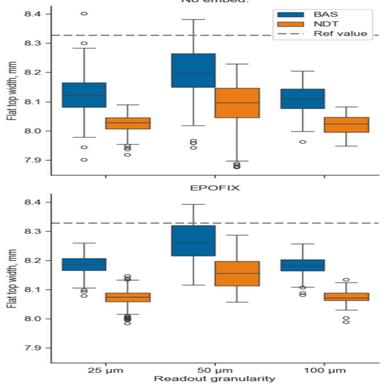
Comparative box plots of diameter measurements of typical round shape UO2 samples with and without EPOFIX embedding. The top plot shows results of sample A121-2023–0014 without embedding, while the bottom plot displays results of sample A121-2023–0013 with EPOFIX embedding. Data series in blue and orange depict variations between BAS and NDT imaging plates. The dashed horizontal line represents the corresponding reference value from the 3D optical profilometer. (For interpretation of the references to color